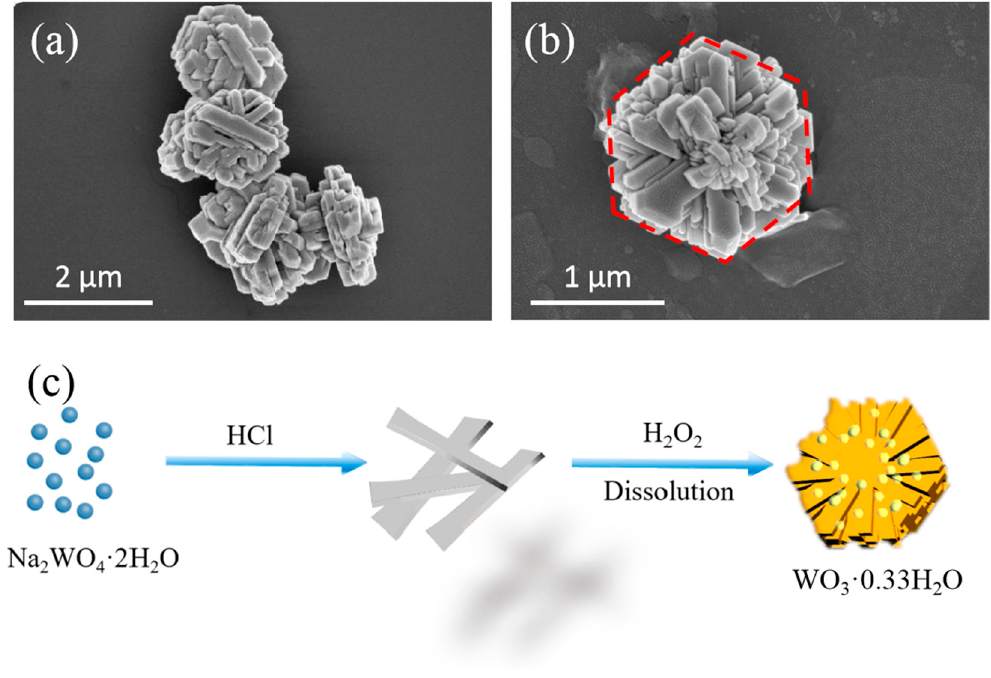
Figure 2. Typical SEM images of ( a , b ) HWHMS and ( c ) proposed growth mechanism of the HWHMS.